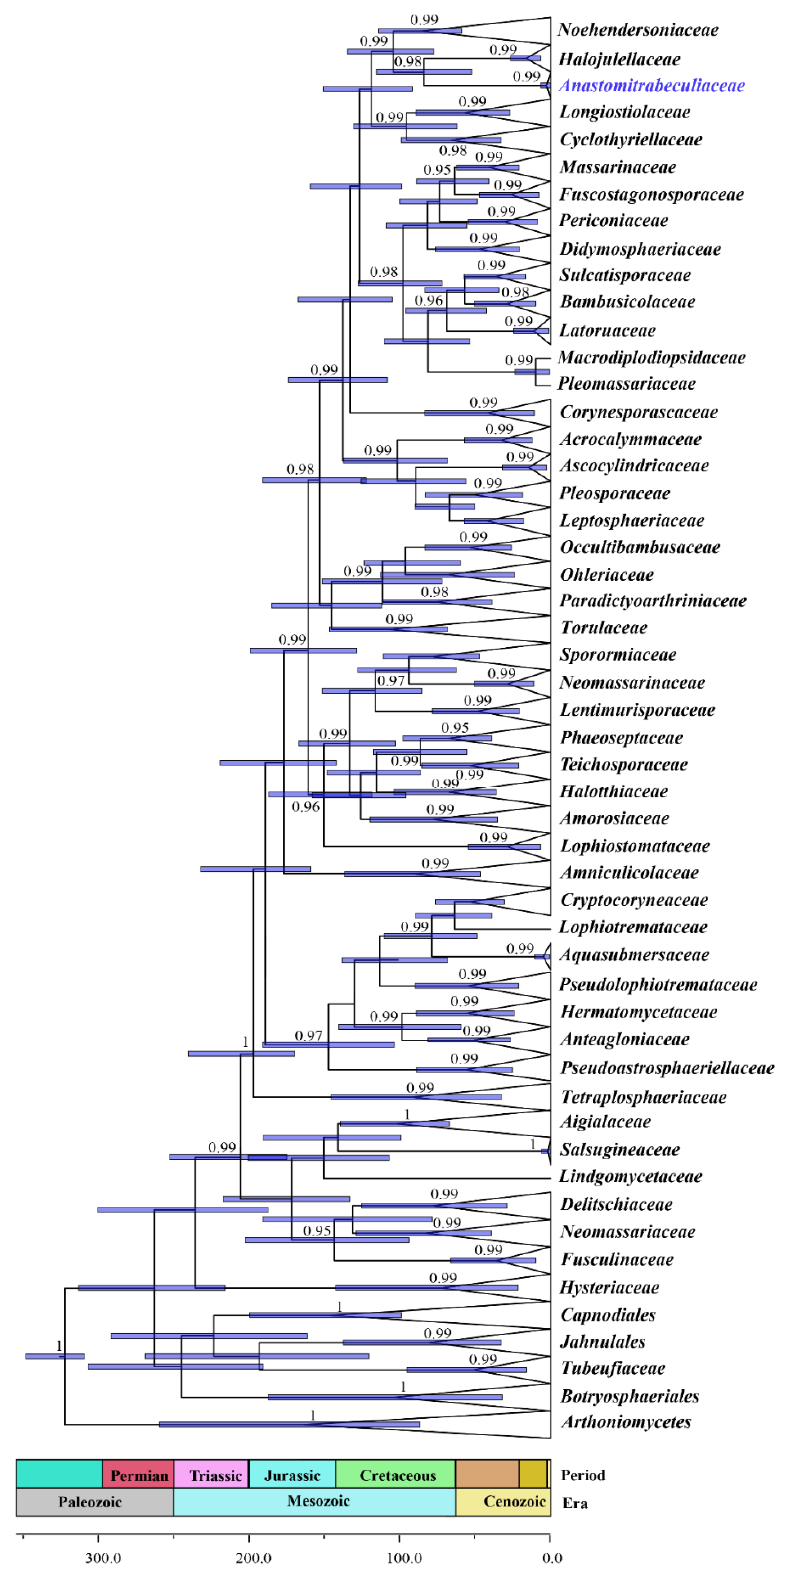
Figure 2. Maximum clade credibility (MCC) tree of families in Dothideomycetes using BEAST. Numbers at nodes indicate posterior probabilities (PP) for node support. Bars correspond to the 95% highest posterior density (HPD) intervals. Posterior probabilities greater than 0.95 are given near the nodes. The new taxon is indicated in blue. Geological time scales are given at the base together with scale in million years ago (MYA) [58].